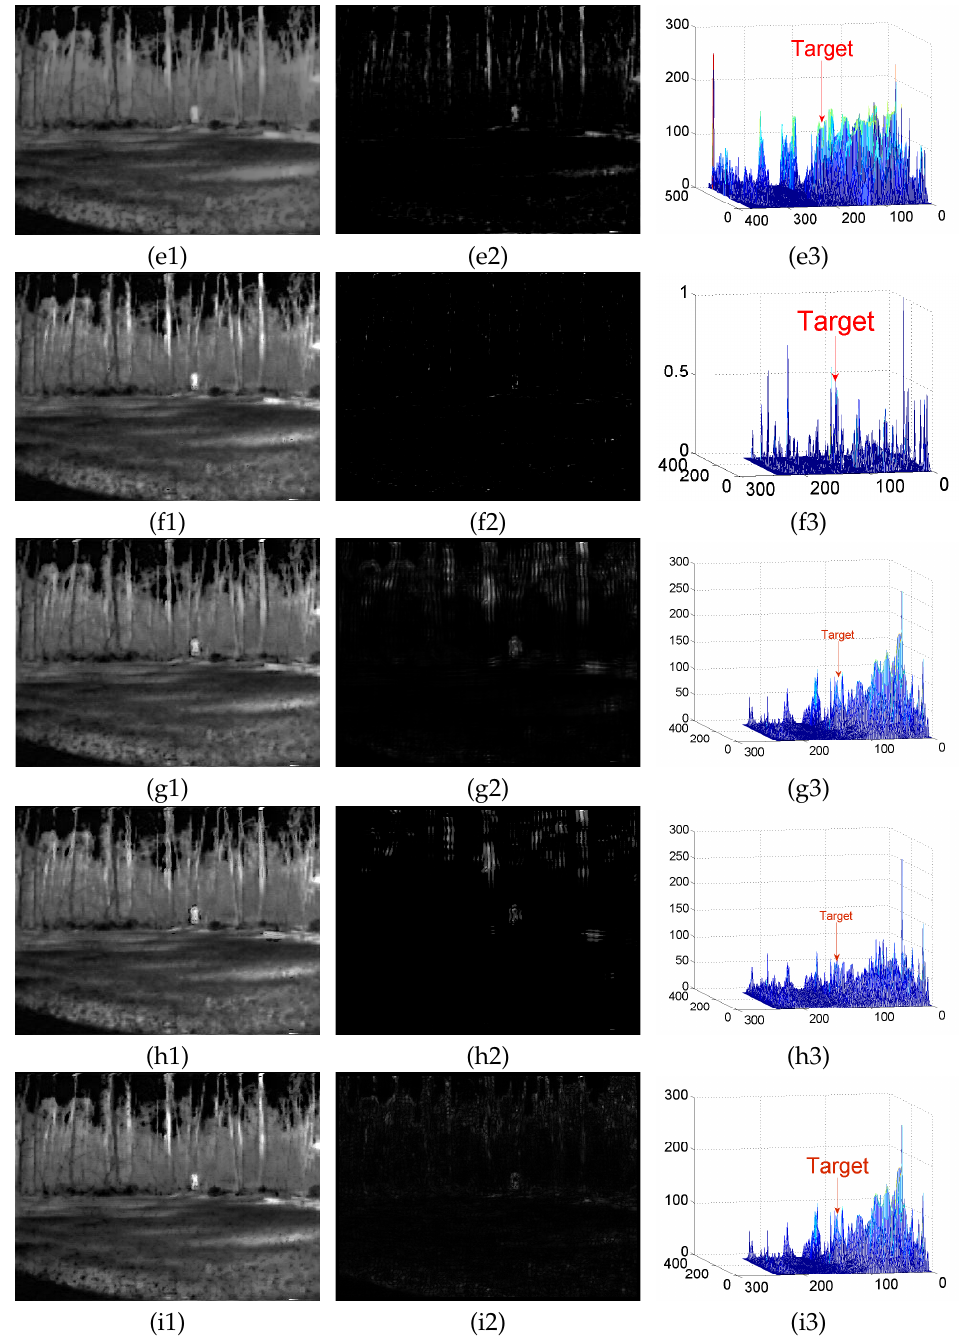
Figure A3. ( a – i ) denote the detection results of the PSTNN, RPCA, TV-PCP, VNTFR, ASTTV, SRWS, C2, C3, and proposed algorithm on sequence D, respectively, where ( a1 – a3 ) denote the background map, the differential map, and the 3D map of the obtained differential map,